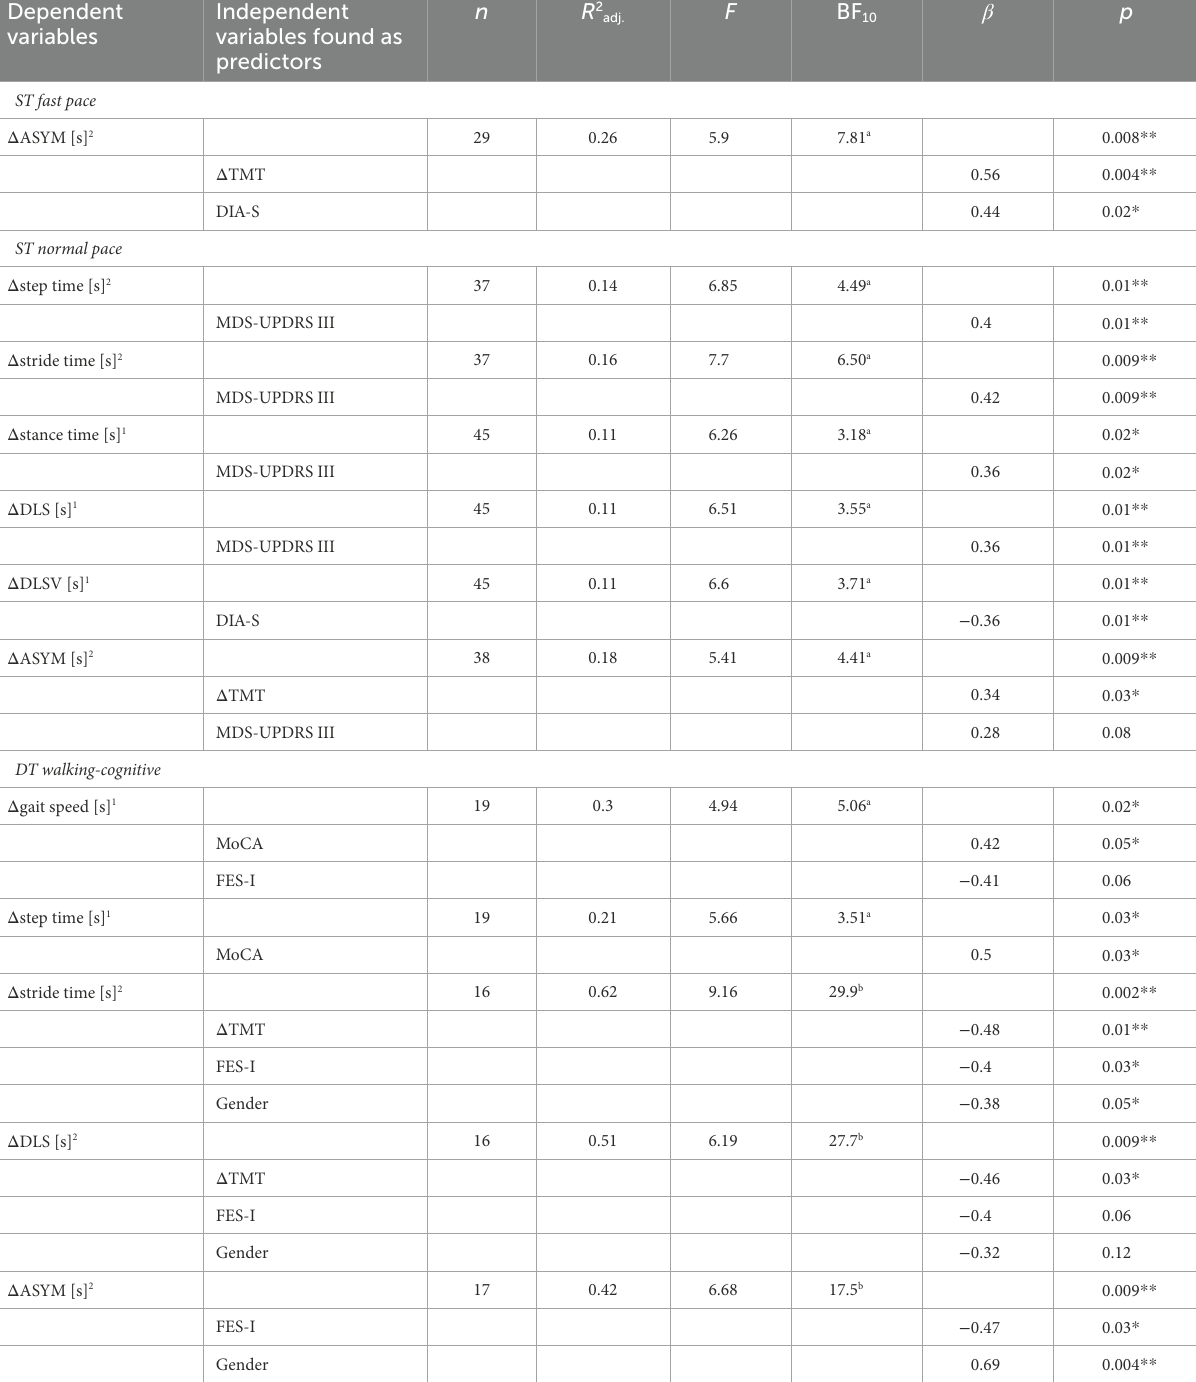
TABLE 2 Backward multiple linear regression models and Bayes factors for significant deltas of walking parameters. Dependent Independent variables variables found as predictors